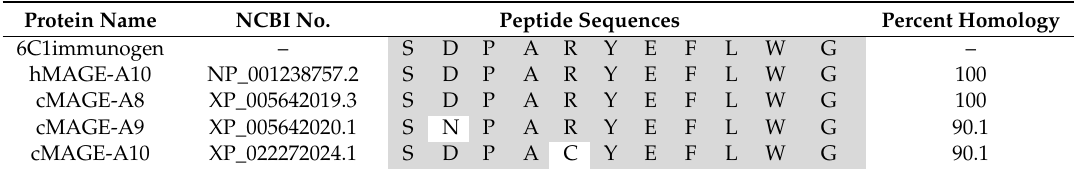
Table 1. Protein sequence and percent homology of 6C1 immunogen with human MAGE-A10 and canine MAGE-A8,-A9 and -A10 of National Center for Biotechnology Informatio (NCBI) databases